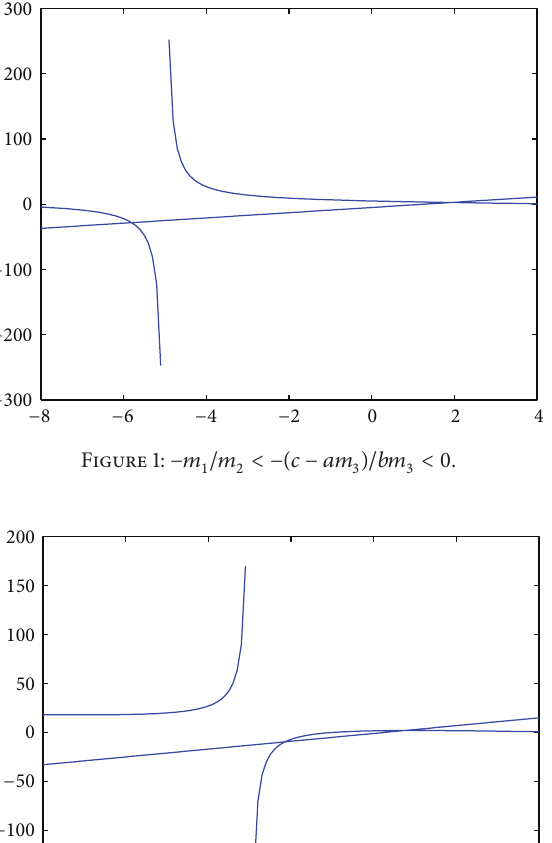
Figure 1: −𝑚 1 /𝑚 2 < −(𝑐 − 𝑎𝑚 3 )/𝑏𝑚 3 < 0 .